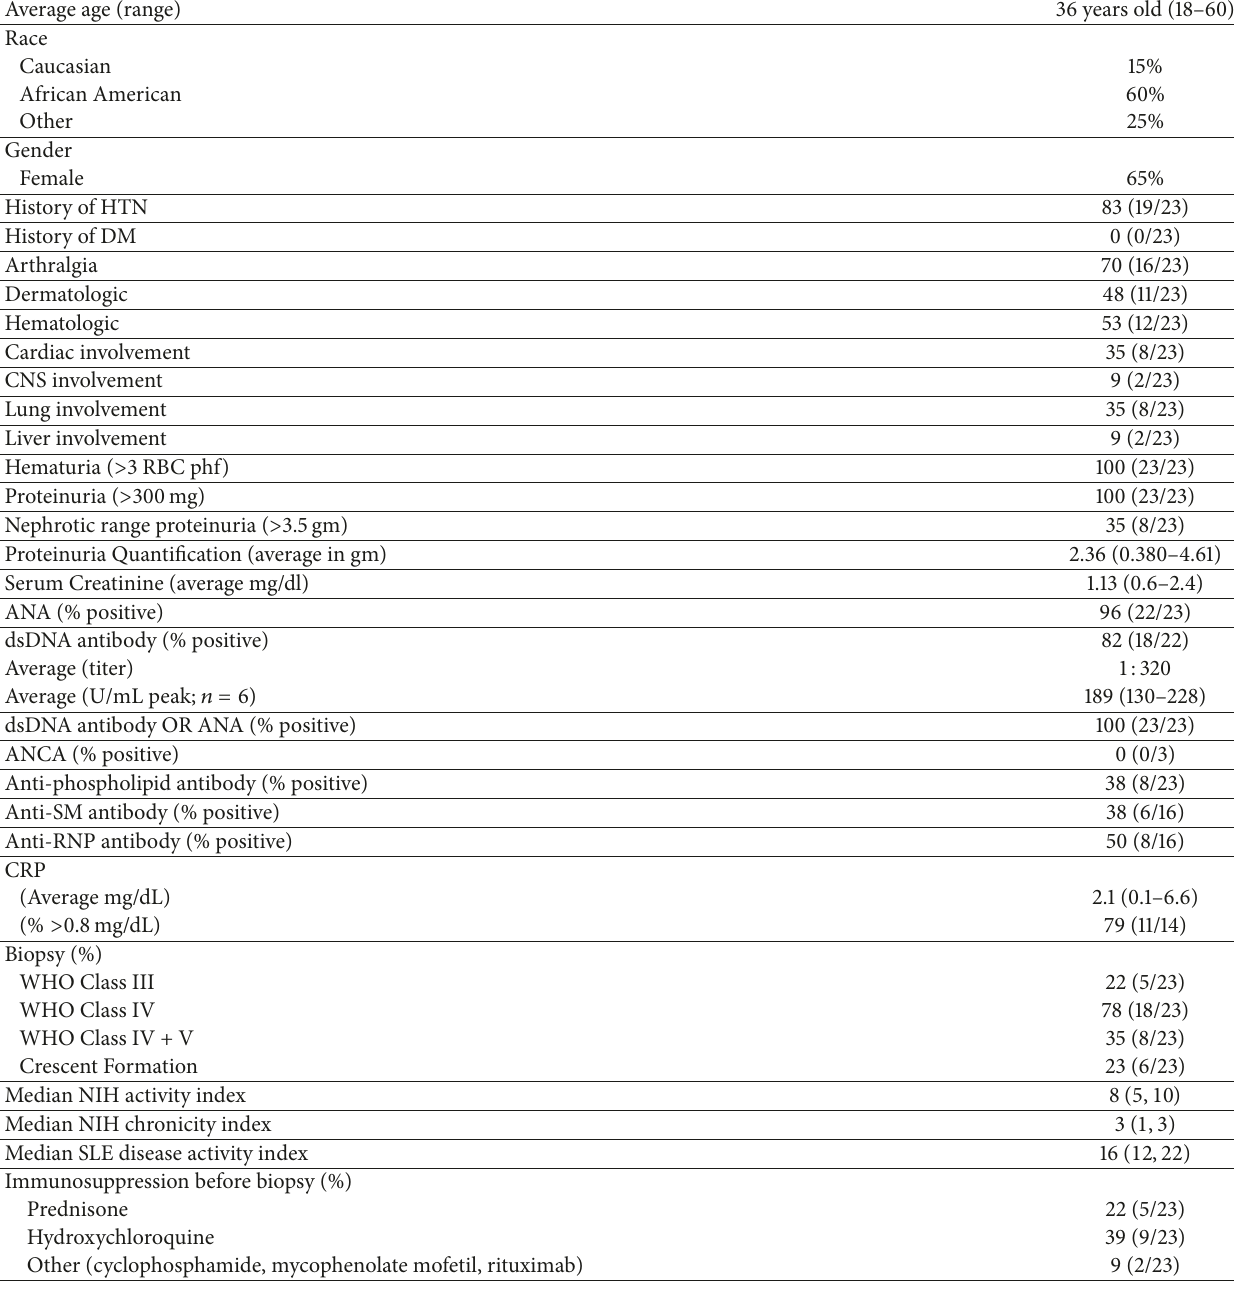
(a) Proliferative lupus nephritis (PLN) background information on based on electronic medical record chart review. Medians presented with 25 % and 75 % values in parentheses for continuous data because they were not normally distributed. Some percentages are accompanied by 𝑛/𝑛 in parentheses. Prednisone dosewas <